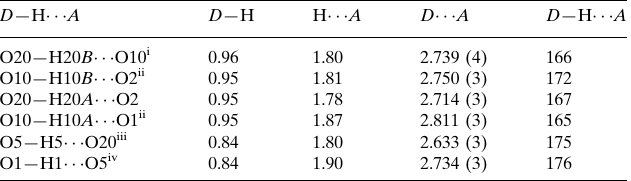
Hydrogen-bond geometry (A˚ , (cid:3)